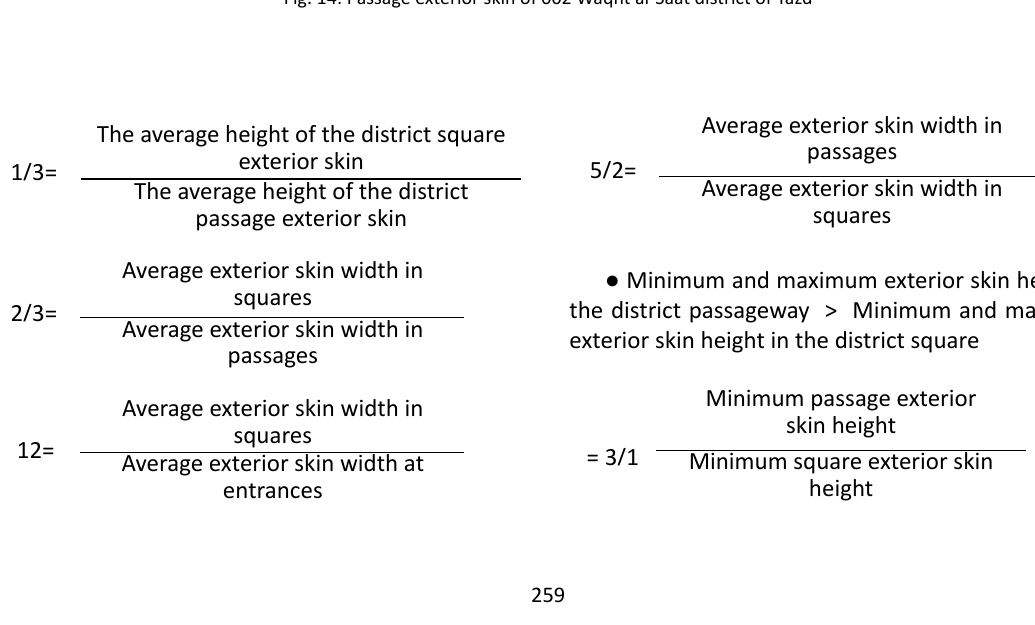
Fig. 14: Passage exterior skin of 002 Waqht al‐Saat district of Yazd